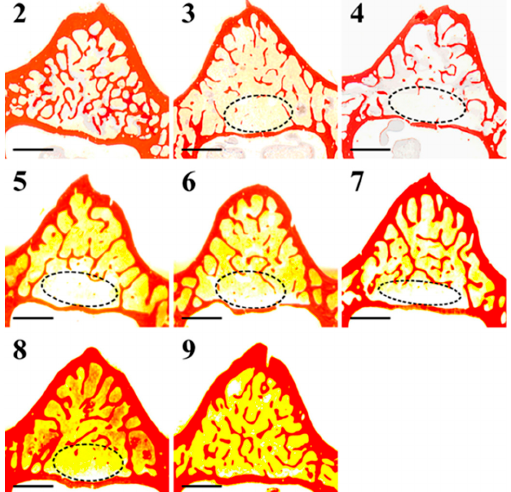
Figure 2. Scans of transversal sections of L5 body from all animal groups (2–9). The encircled areas show, in the posterior portion of the vertebral body, the almost-total absence of trabecular bone. Scale bar: 1 mm.